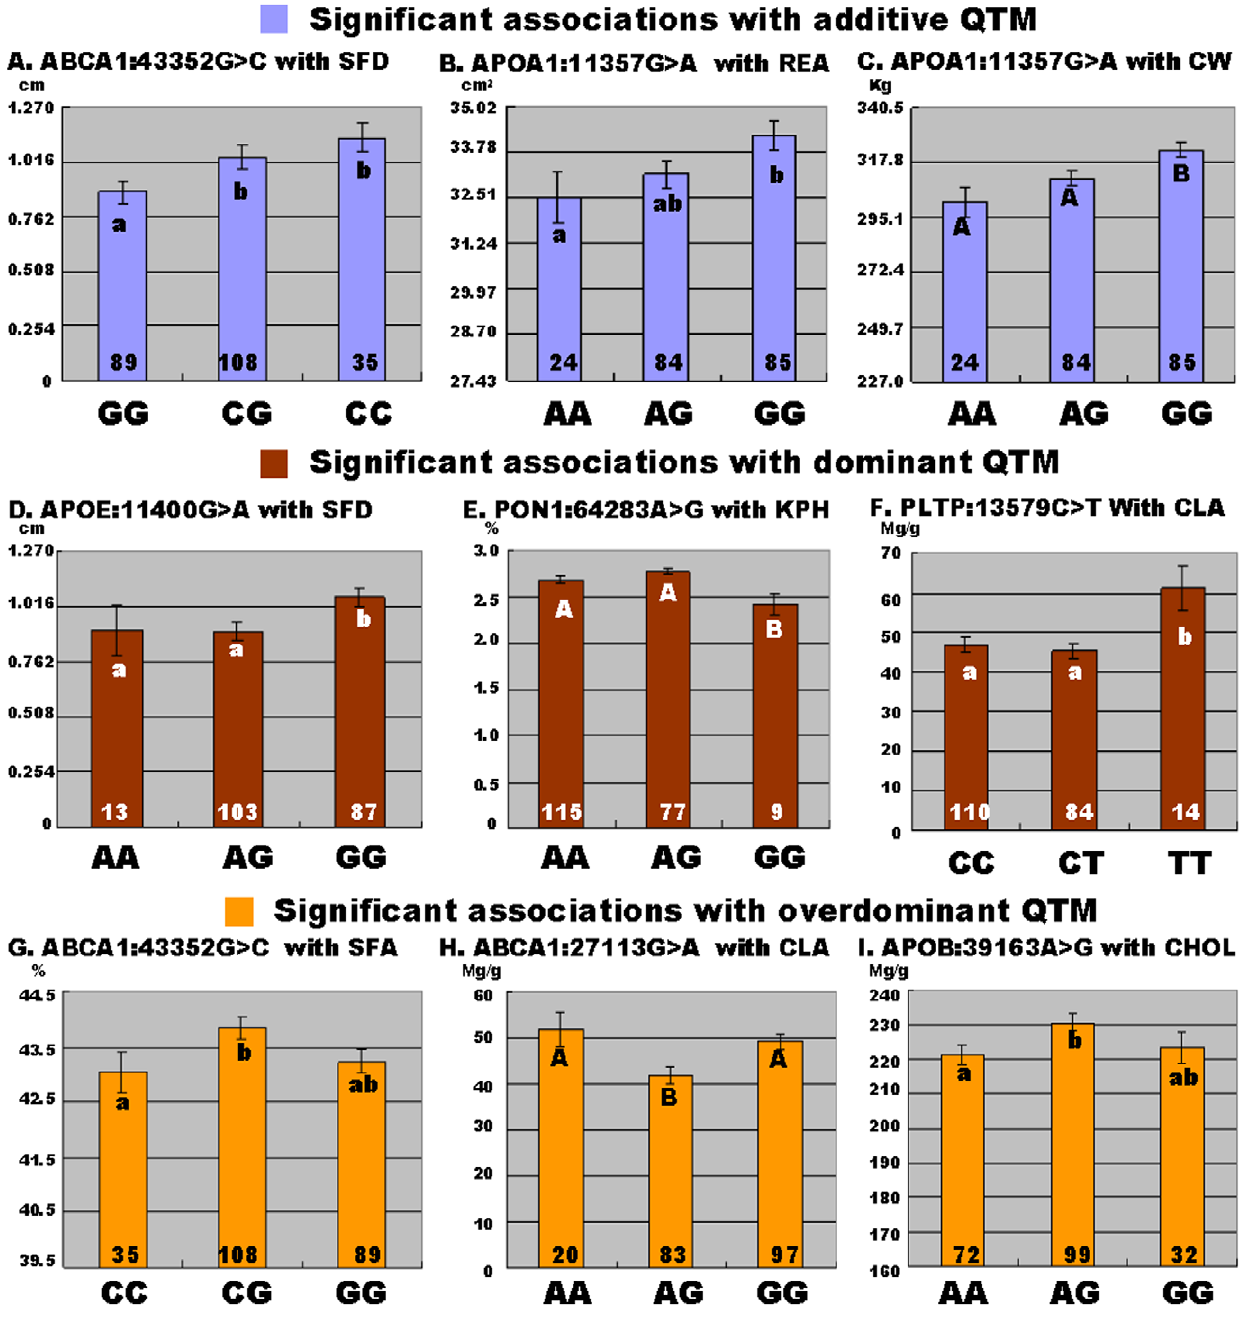
Figure 2. Association of SNP markers with fat decomposition and muscle growth. P values are adjusted by Bonferroni correction. The different capital letters between different genotypes within the same marker means the difference reaches the significance level of adjusted P , 0.05, while those with difference between genotypes marked by different lowercase letters is suggestive (adjusted P , 0.10). The same letters between genotypes indicate no suggestive/significant difference (adjusted P . 0.10). The number within the bars represents the number of animals within each genotype group.